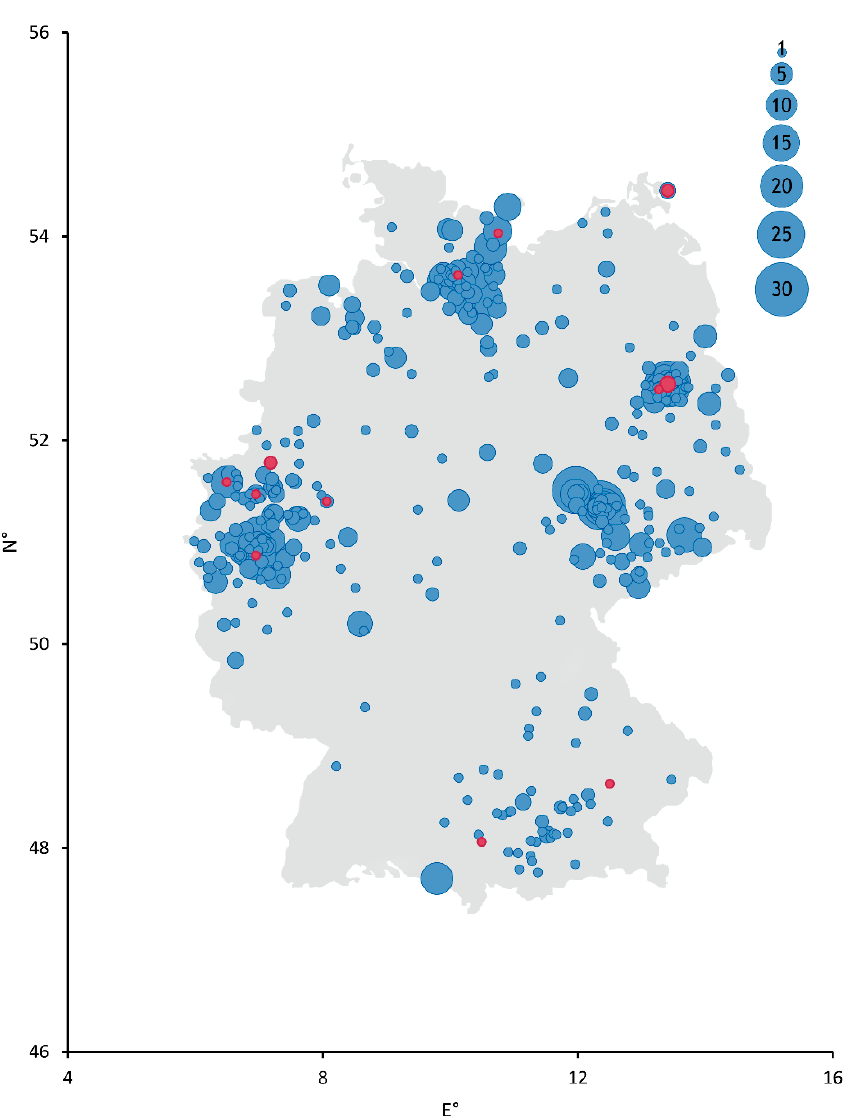
Figure 1. Schematic depiction of collection sites across Germany. Diameter of points correlates with the number of samples collected from each site. Serum samples that tested positive for antibodies against SARS-CoV-2 by ELISA and an indirect immunofluorescence test (iIFT) are colored red. Negative samples are colored blue. N° = decimal degrees of longitude and E° = decimal degrees of latitude.